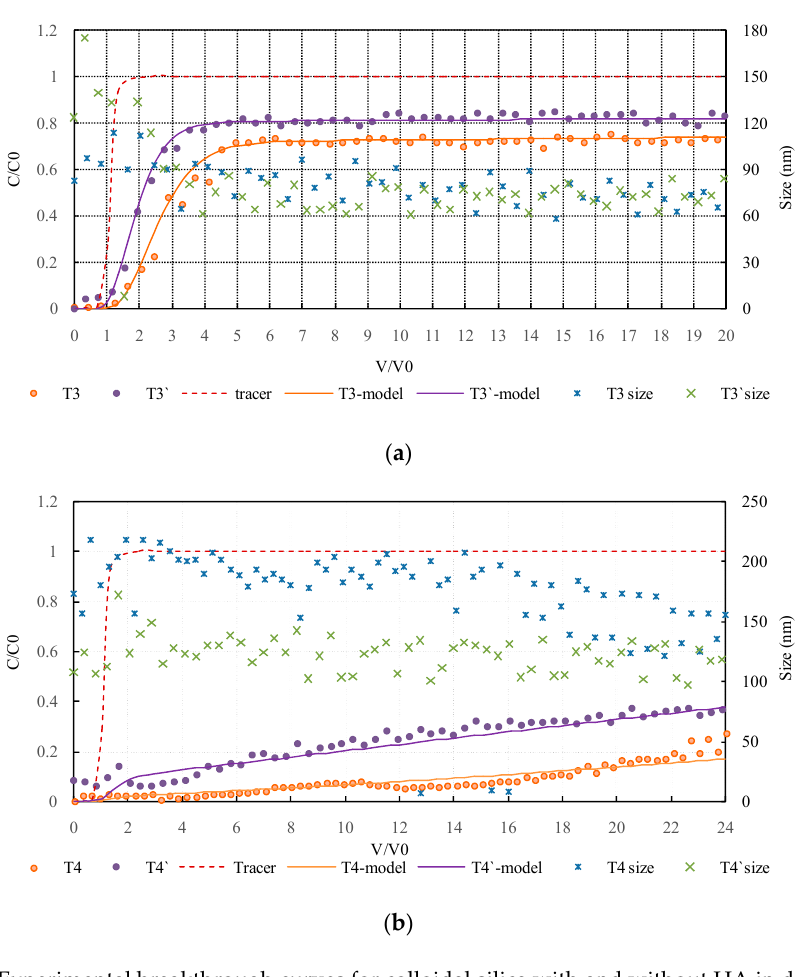
Figure 6. Experimental breakthrough curves for colloidal silica with and without HA in divalent ion solution: ( a ) IS = 0.0093 M; ( b ) IS = 0.013 M.